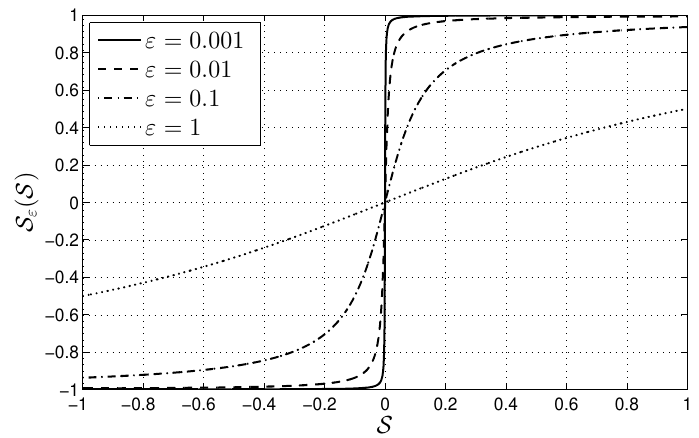
Figure 5. Sigmoid function S ε for various ε